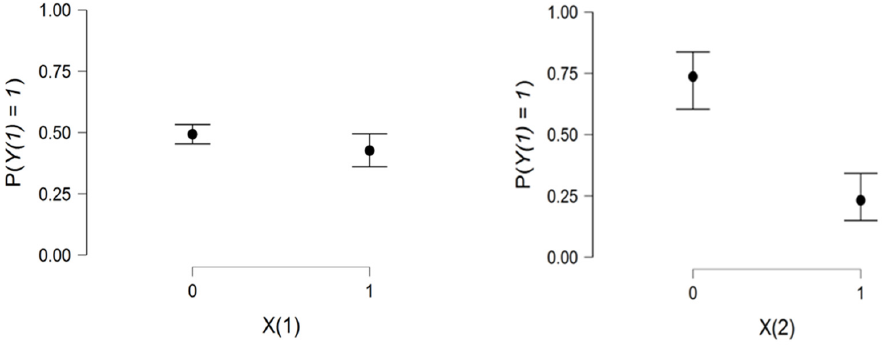
Figure 1. The relationship between age and the dependent variable 𝑌 (cid:2870) in both models Figure 2 confirms the importance of preventive measures against COVID ‐ 19 infection for vaccinated people. This may be observed in the range between 𝑋 (cid:2869) and 𝑋 (cid:2870) .